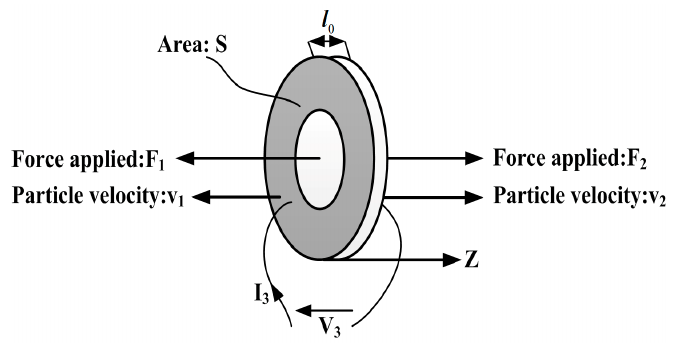
Figure 3. Piezoelectric ceramic ring vibrating in thickness mode.